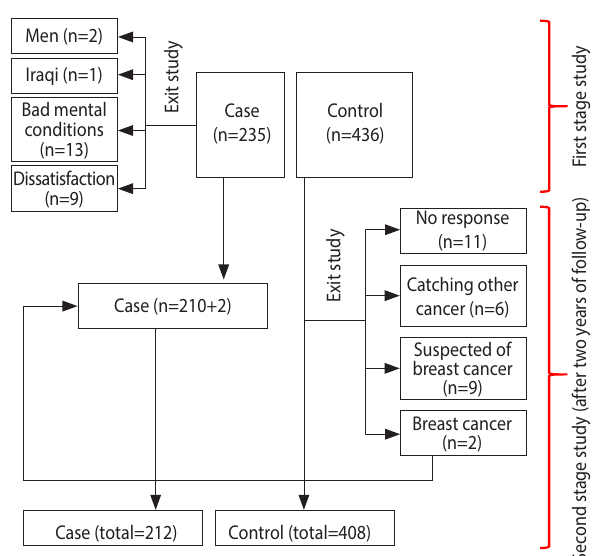
Figure 1. Flowchart of the research process. Figure 1. Chart of the research implementation